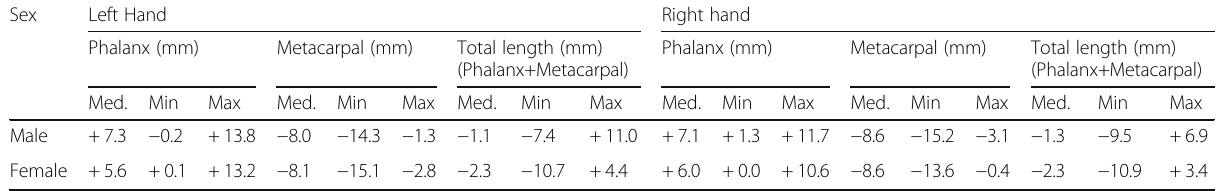
Table 3 Difference in lengths (ring finger – index finger) Sex Left Hand Right hand Phalanx